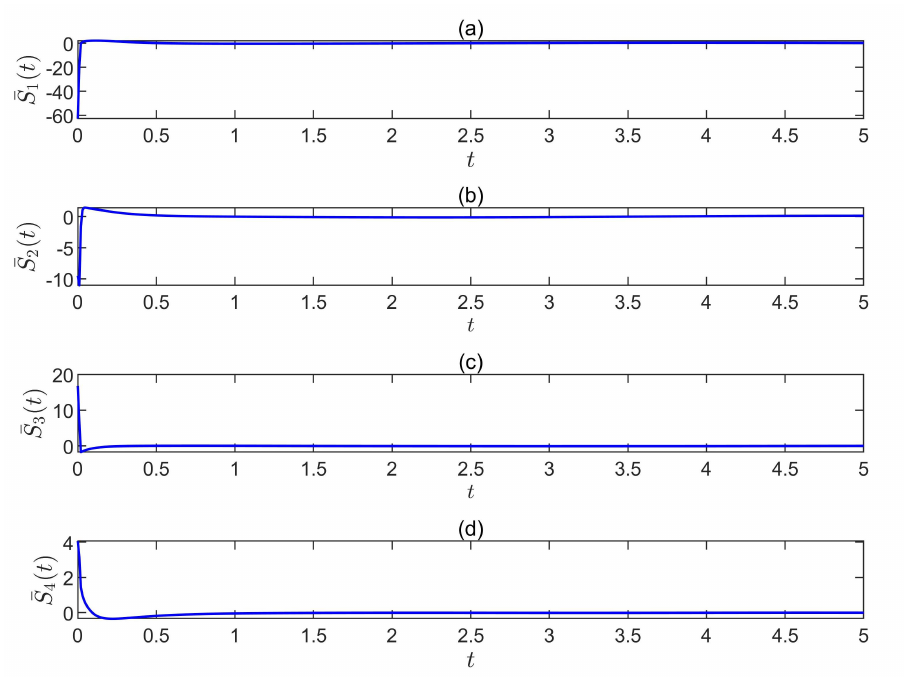
Figure 2. The sliding-mode surface of the system: ( a ) the ¯ S 1 − t space; ( b ) the ¯ S 2 − t space; ( c ) the ¯ S − t space; ( d ) the ¯ S − t 3 4